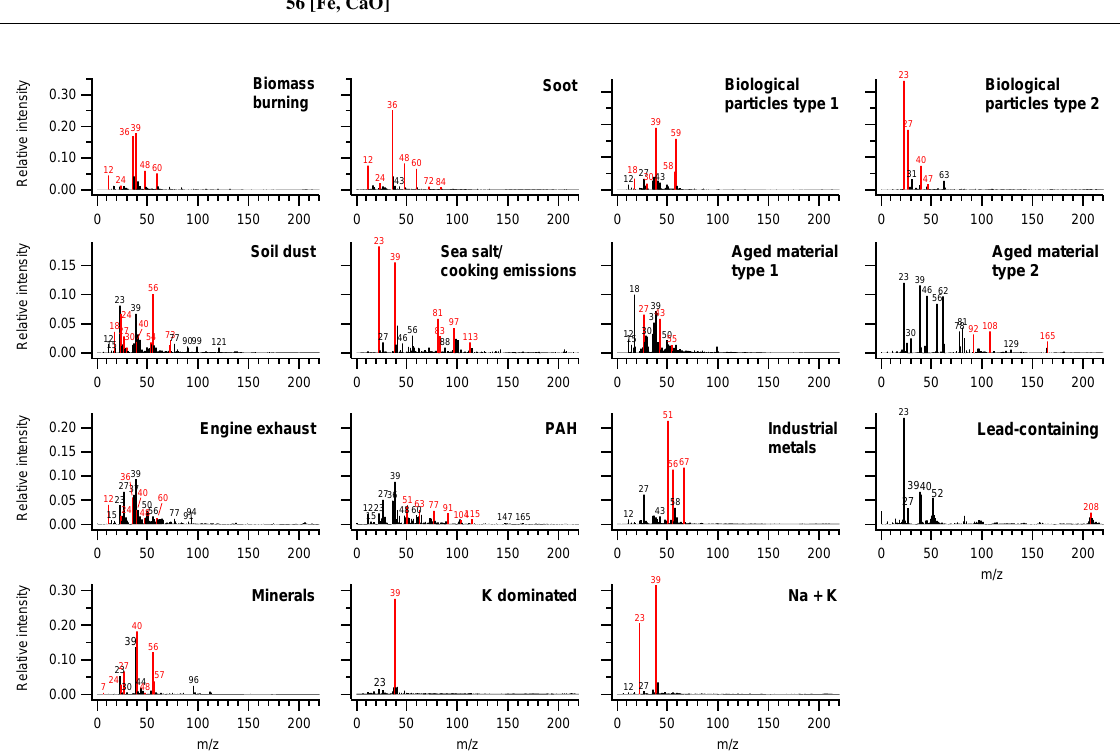
Figure 2. Average spectra (only cations) of all identified particle types from the JFJ measurements. The classification was done according to the results from the laboratory studies (Table 2). The red highlighted peaks indicate the marker peaks used for identification of the particle